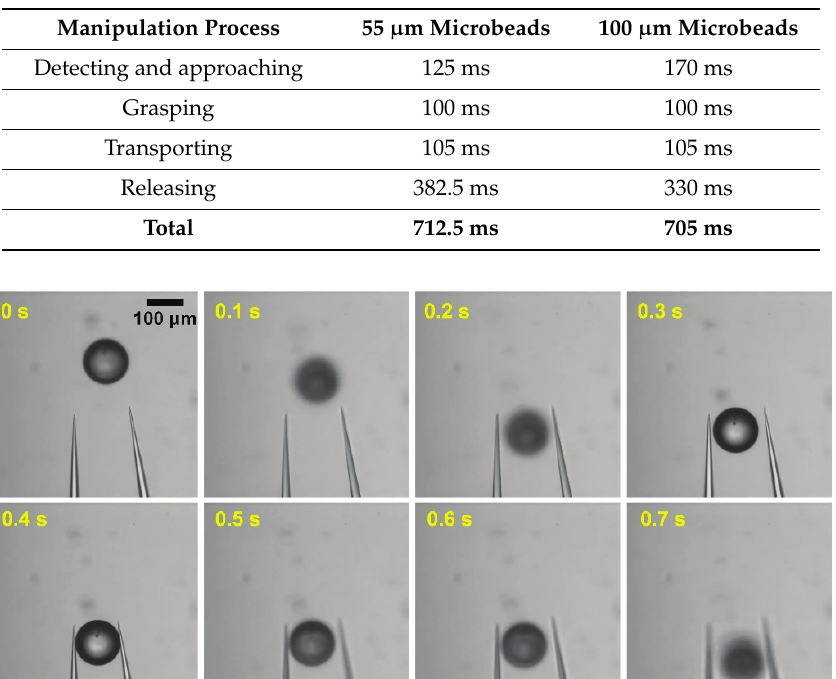
Table 2. Average required time for manipulation of 55 µ m and 100 µ m microbeads.